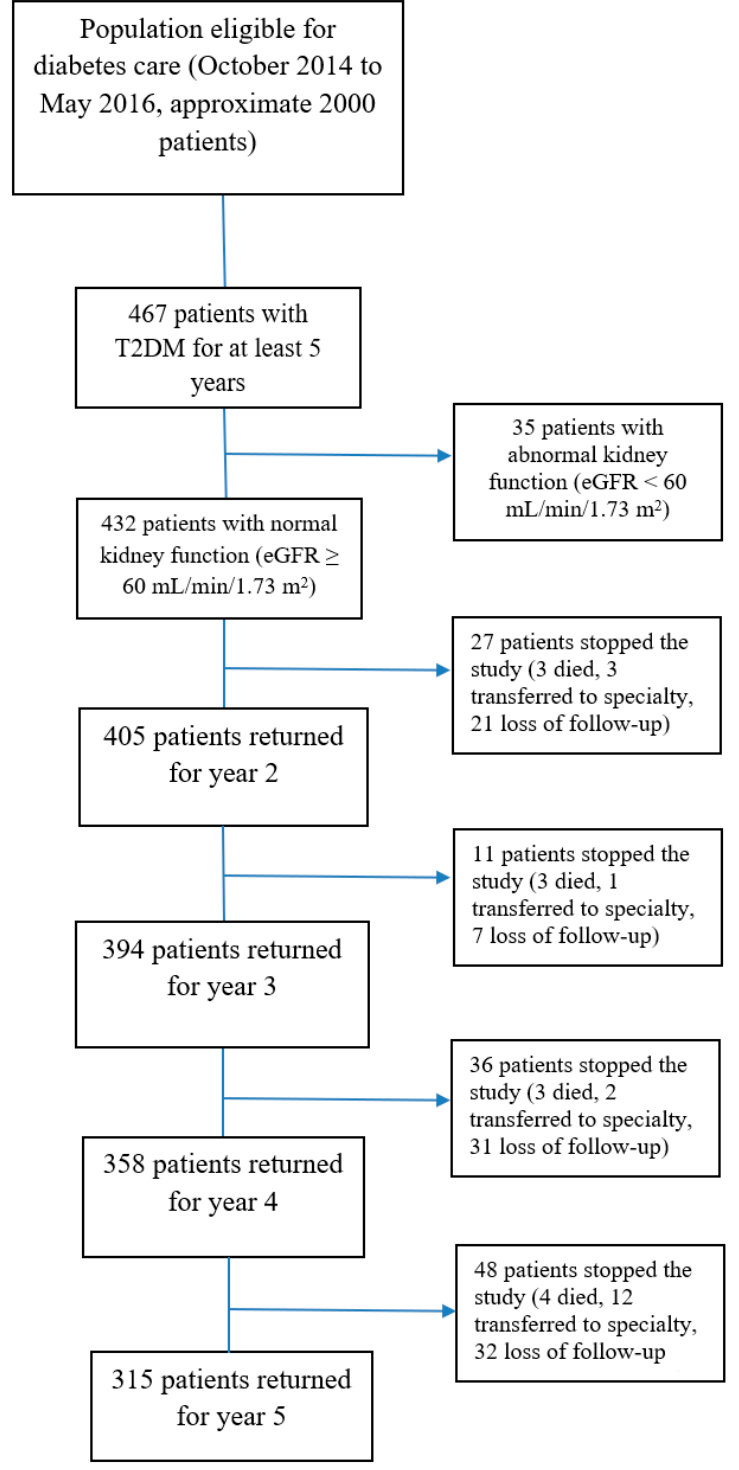
Figure 1. Study Flow Diagram. “Transferred to specialty”: the patients were transferred to nephrology, cardiology or neurology depending on the clinical severity.